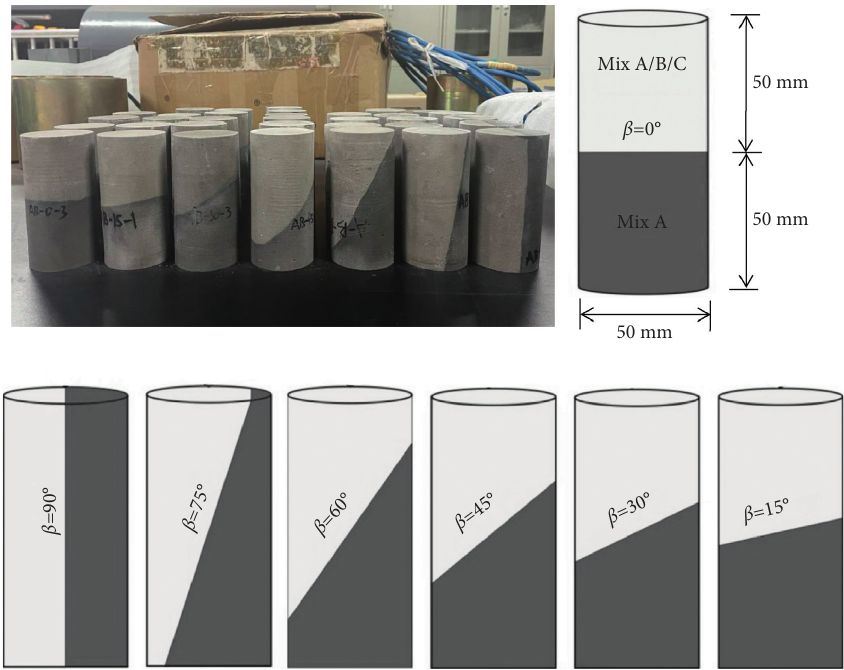
Figure 4: The finished layered rock specimens with bedding plane inclination angles β from 0 ° to 90 °